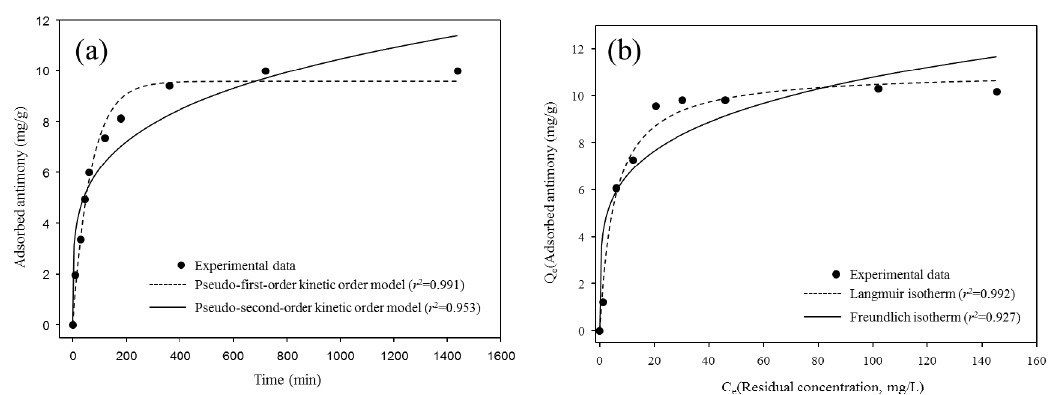
Figure 6. The adsorption kinetics ( a ) and isotherms ( b ) of antimony using BP (25 °C). Table 2. The kinetic constants for removal of antimony using BP.